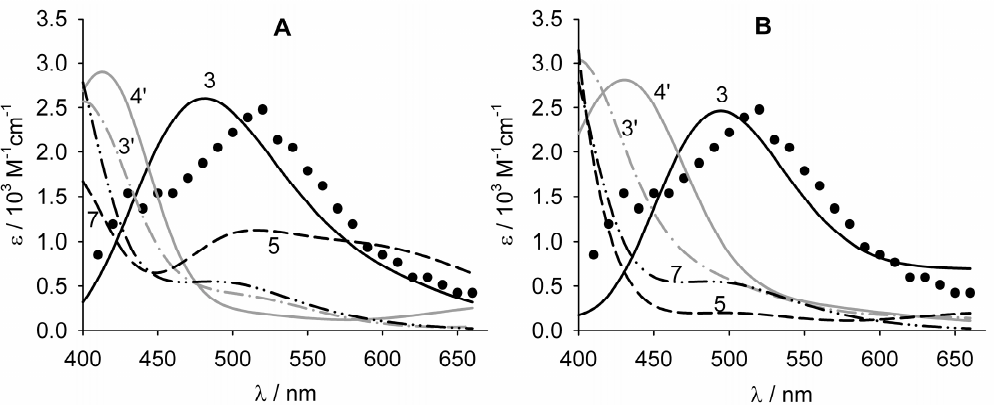
Figure 3. Calculated ultraviolet–visible (UV–vis) spectra of the neutral radicals of quercetin in the gas phase ( A ) or in water ( B ), compared to the experimental spectrum measured at pH 2.6 ( ● ) by Jovanovich et al. [38]. Numbers indicate the position of the radical.